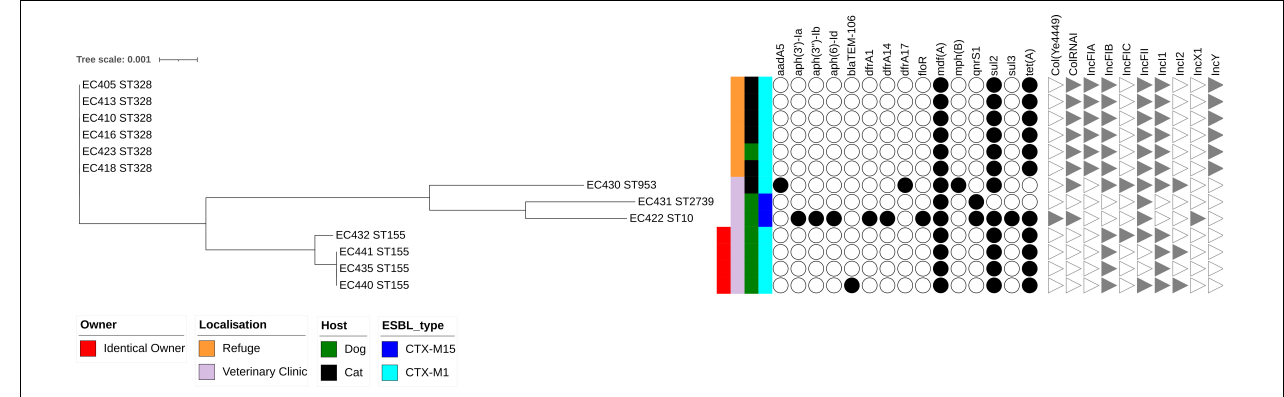
FIGURE 1 | Maximum likelihood phylogenetic tree of 13 extended-spectrum β -lactamase-producing Escherichia coli isolates collected in Guadeloupe based on multiple sequence alignments of the 3,429 core genome loci. Sequence type (ST) is indicated for each isolate. Hosts, ESBL genes, site of inclusion, and an identical owner are indicated by vertical colored strips. Other antibiotic resistance genes characterized by ResFinder and Inc. incompatibility group characterized by PlasmidFinder are indicated by black dots and gray triangles,